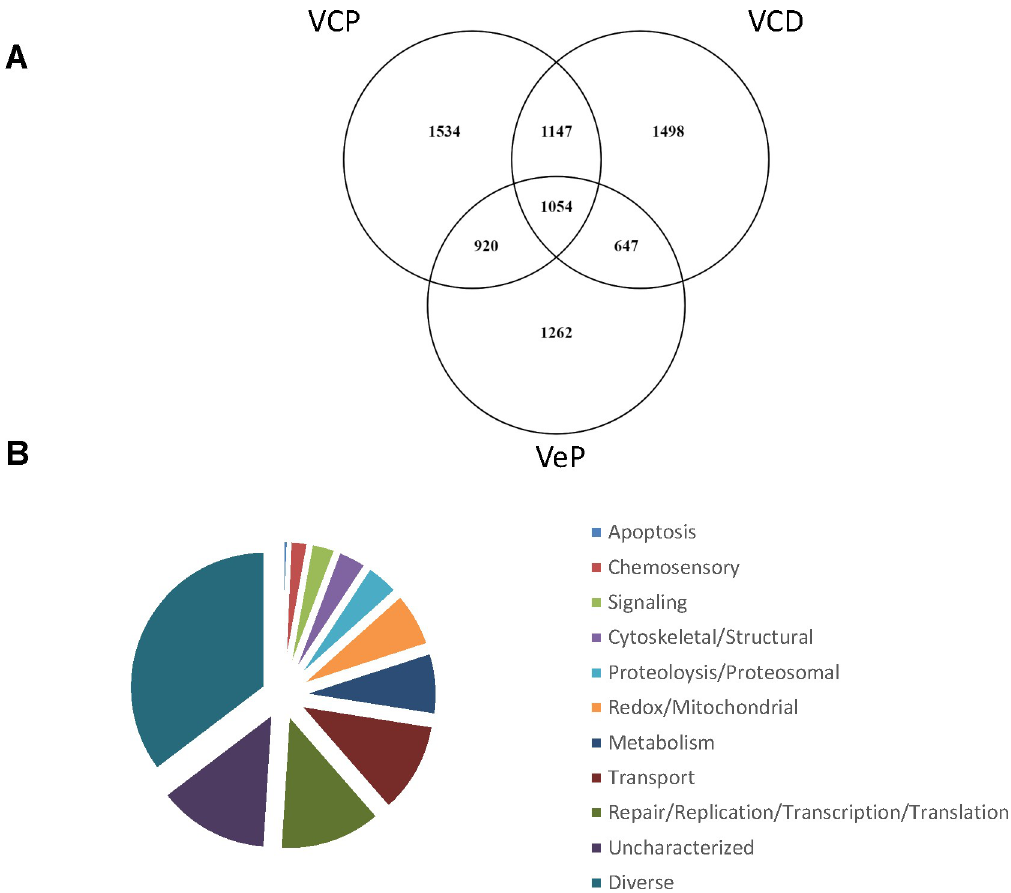
Fig 2. Genes with statistical association to resistance were common among all three collections (n = 1054). A) Venn diagram indicates common genes among all three treatment groups; Viva Caucel permethrin (VCP), Viva Caucel deltamethrin (VCD), and Vergel permethrin (VeP). B) Functional categories for genes in the high association set are listed from least abundant (top) to most abundant in the order of the diagram slices. X-axis shows beginning and end locations of polymorphisms on each